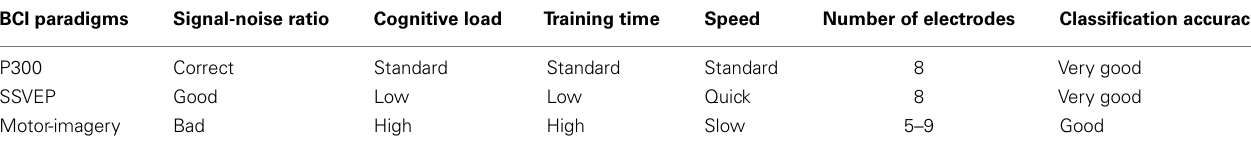
Table 7 | Comparison of different BCI paradigms for the EEG module